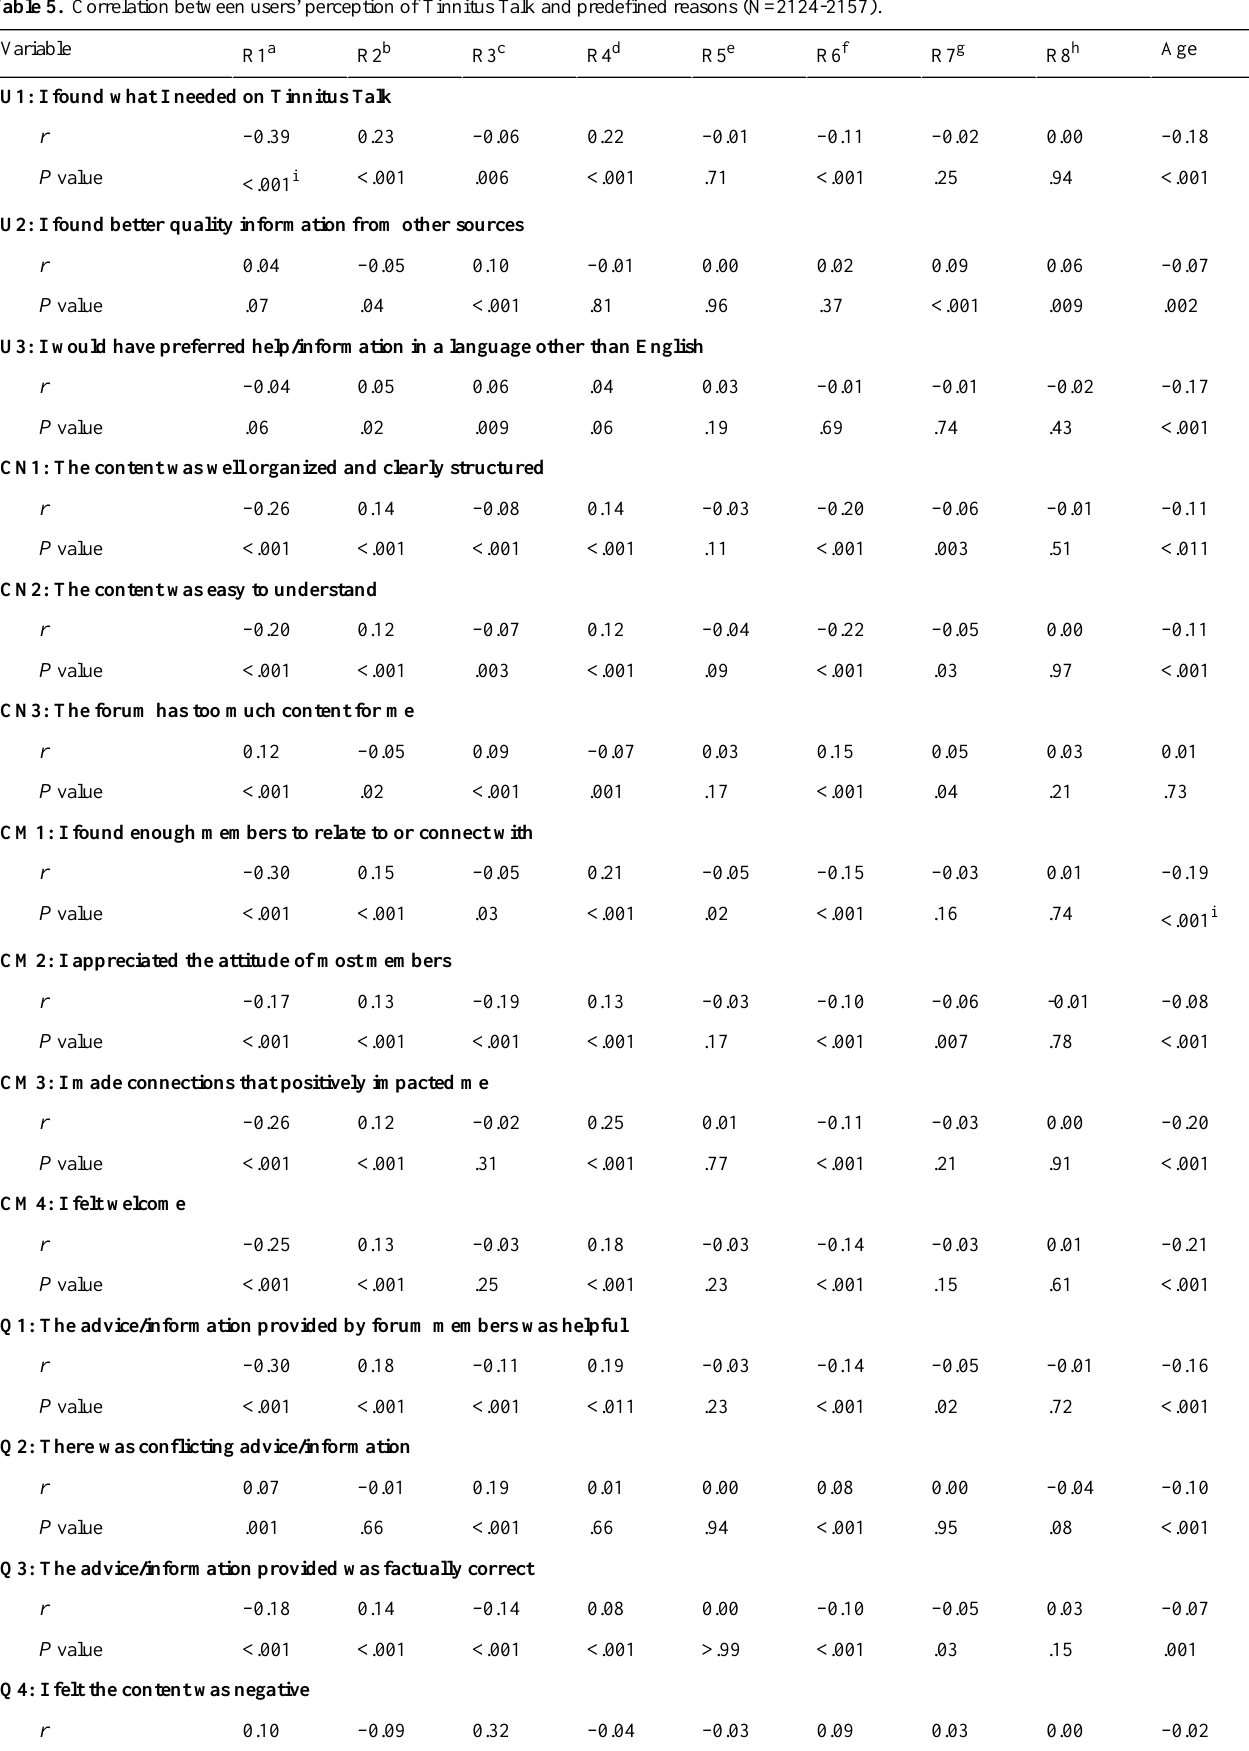
Table 5. Correlation between users’perception of Tinnitus Talk and predefined reasons